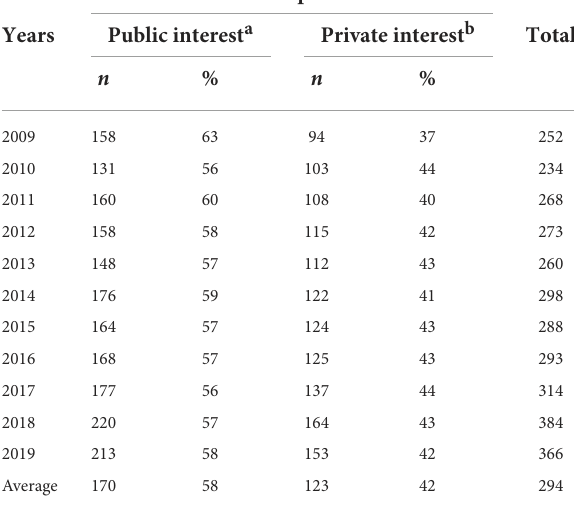
TABLE 5 Total number of participants (including member state delegations and observer delegations) by interest type attending CCNFSDU 1 ,